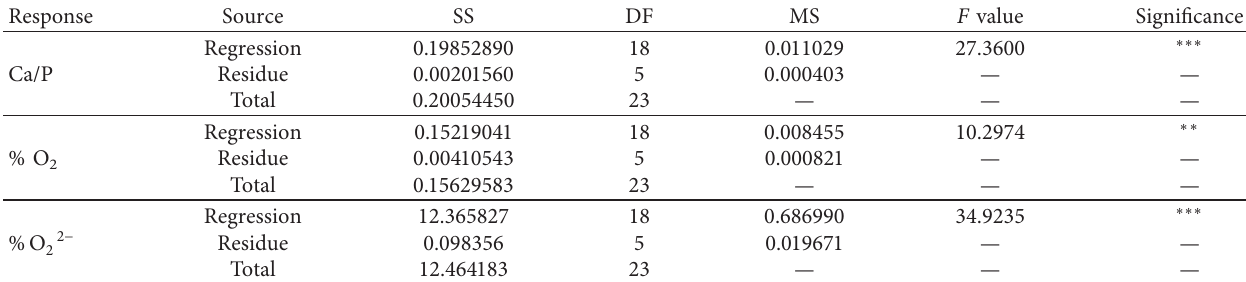
Table 3: ANOVA for full quadratic models.